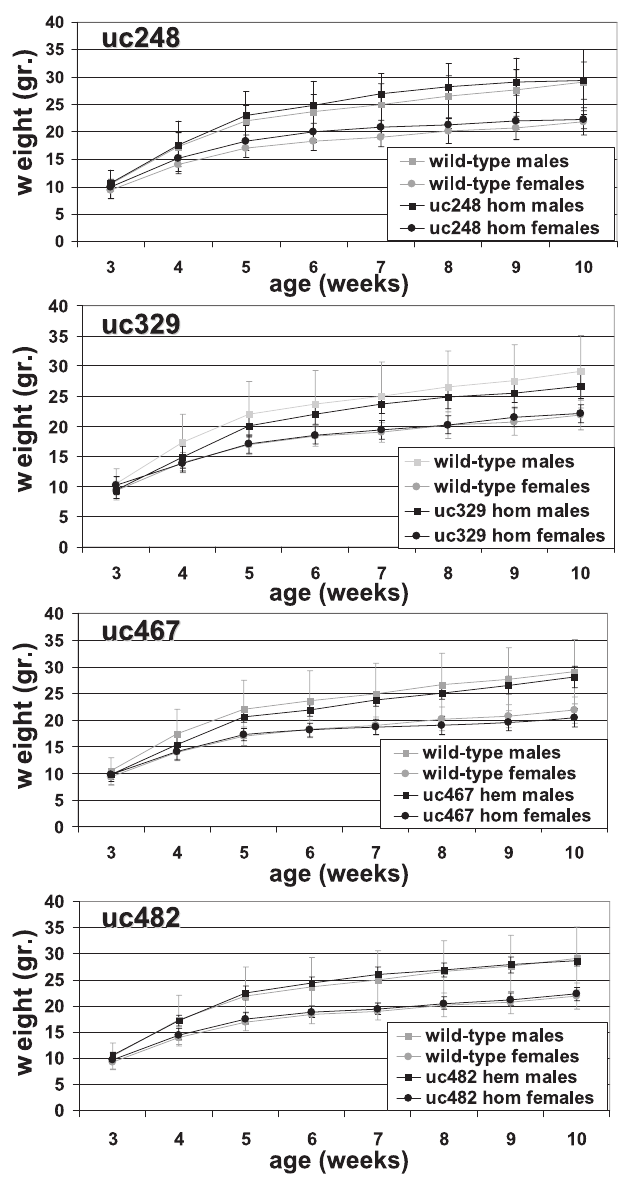
Figure 2. Growth Curves of Each Ultraconserved Element Knockout Mouse Strain Error bars indicate standard deviation. hem, hemizygous; hom,